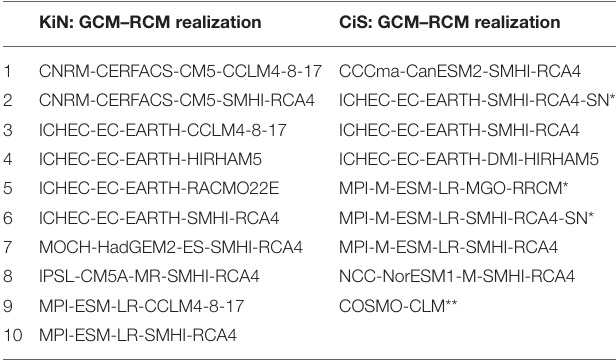
TABLE 2 | GCM–RCM combinations used in KiN from the EURO-CORDEX ensemble and CiS for the Arctic-CORDEX ensemble (see page 144 in KiN and page 192 in CiS for references and